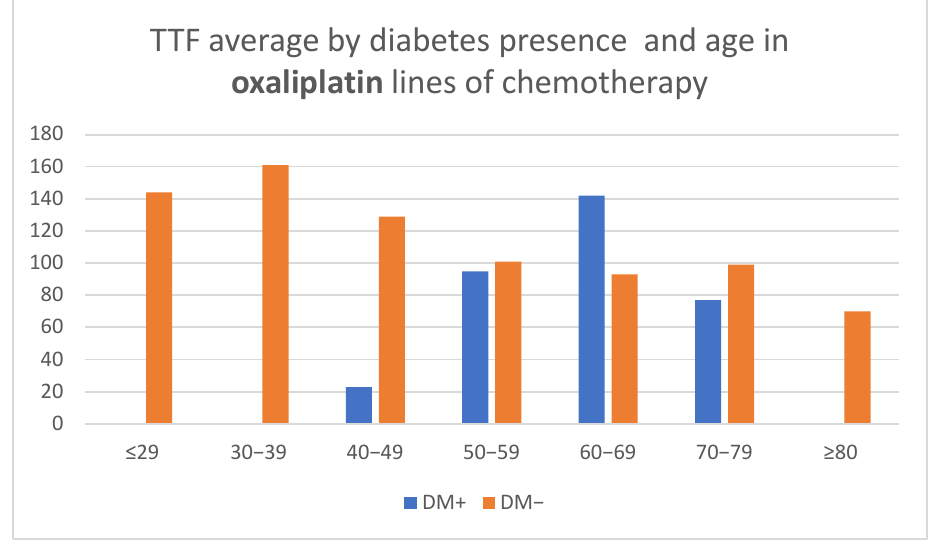
Figure 3 . Time to treatment failure (TTF) average by diabetes presence and age in oxaliplatin lines of chemotherapy .